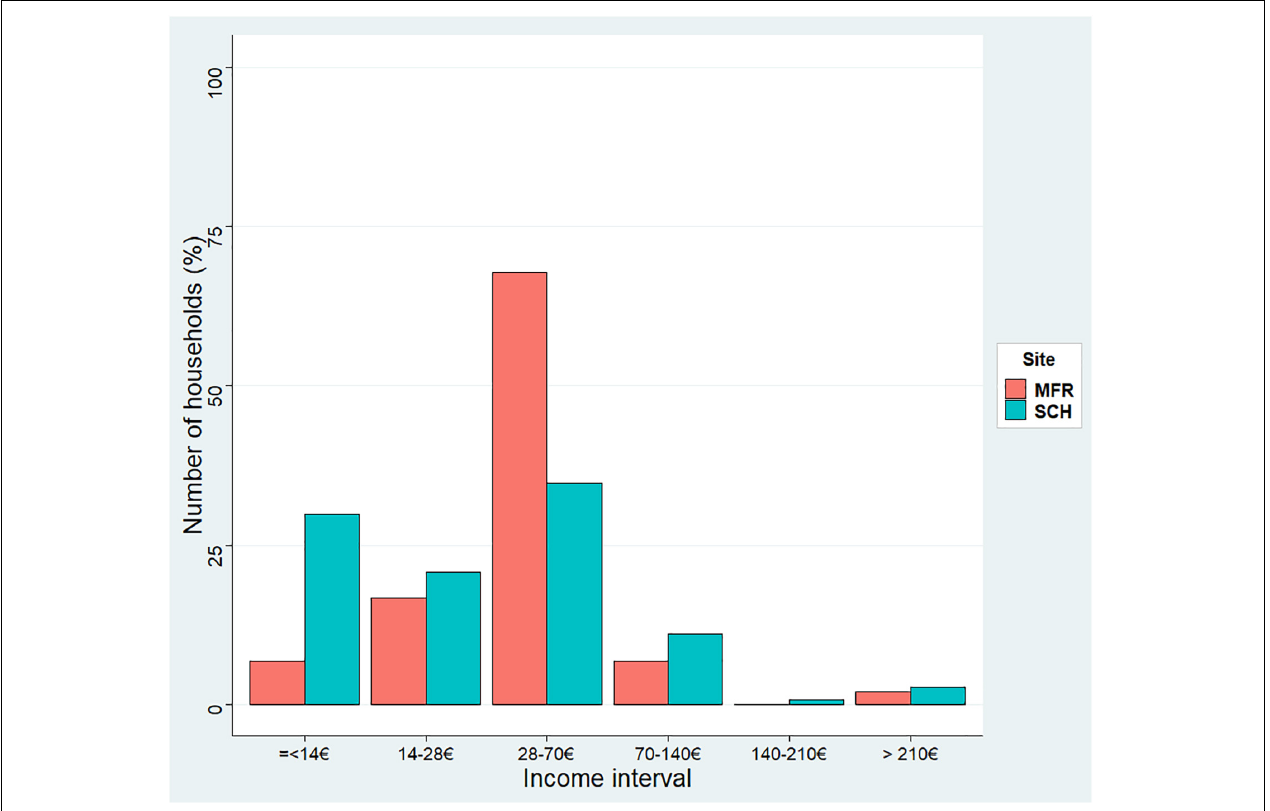
FIGURE 4 | Percentage of households in MFR and SCH per income (in